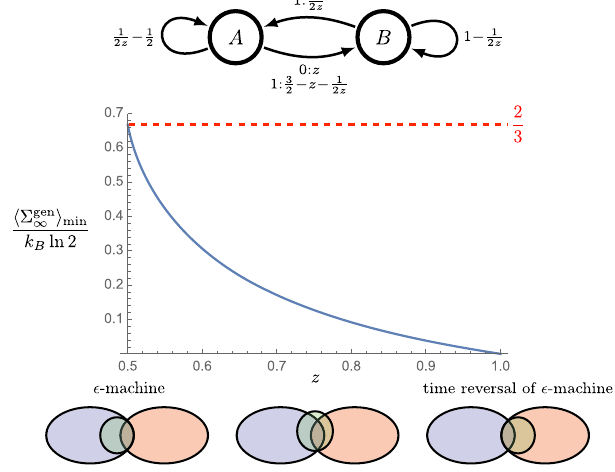
FIG. 7. Top: A parametrized family of HMMs that generate the golden mean process for z ∈ ½ : 5 ; 1 (cid:2) . Middle: As parameter z increases, the information stored in the hidden states about the output past decreases. At z ¼ 0 . 5 , the HMM is the ϵ -machine, whose states are a function of the past. At z ¼ 1 . 0 , the HMM is the time reversal of the reverse-time ϵ -machine, whose states are a function of the future. The modularity dissipation decreases monotonically as z increases and the hidden states ’ memory of the past decreases. Bottom: Information diagrams correspond- ing to the end cases and a middle case. Labeling is the same as in Fig.